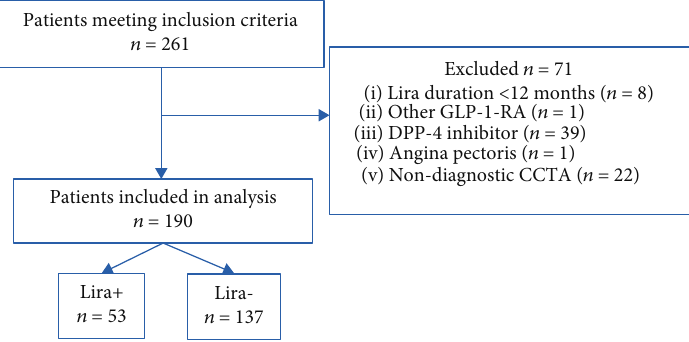
Figure 1: Study fl ow chart depicting recruitment, inclusion, exclusion, and clinically allocated treatment groups.